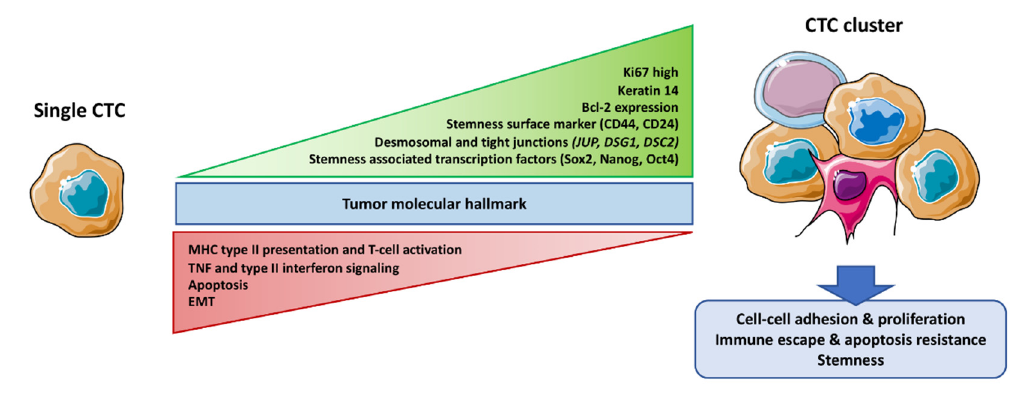
Figure 2. Molecular di ff erences between CTC clusters and single CTCs. CTC clusters like single CTCs harbor the molecular hallmark of their primary tumor. By contrast, multiple pathways like cell–cell adhesion (desmosomes), stemness (surface markers and associated transcription factors), and proliferation (higher KI67) are up-regulated in CTC clusters. On the other hand, apoptosis and immune activation pathways like Major Histocompatibility Complex MHC type II presentation, T-cell activation, and Tumor Necrosis Factor TNF signaling are down-regulated. Epithelial to mesenchymal transition status of CTC clusters is crucial for single CTC migratory property but is debated for clusters. This figure was performed using free online Servier Medical Art at www.servier.com.